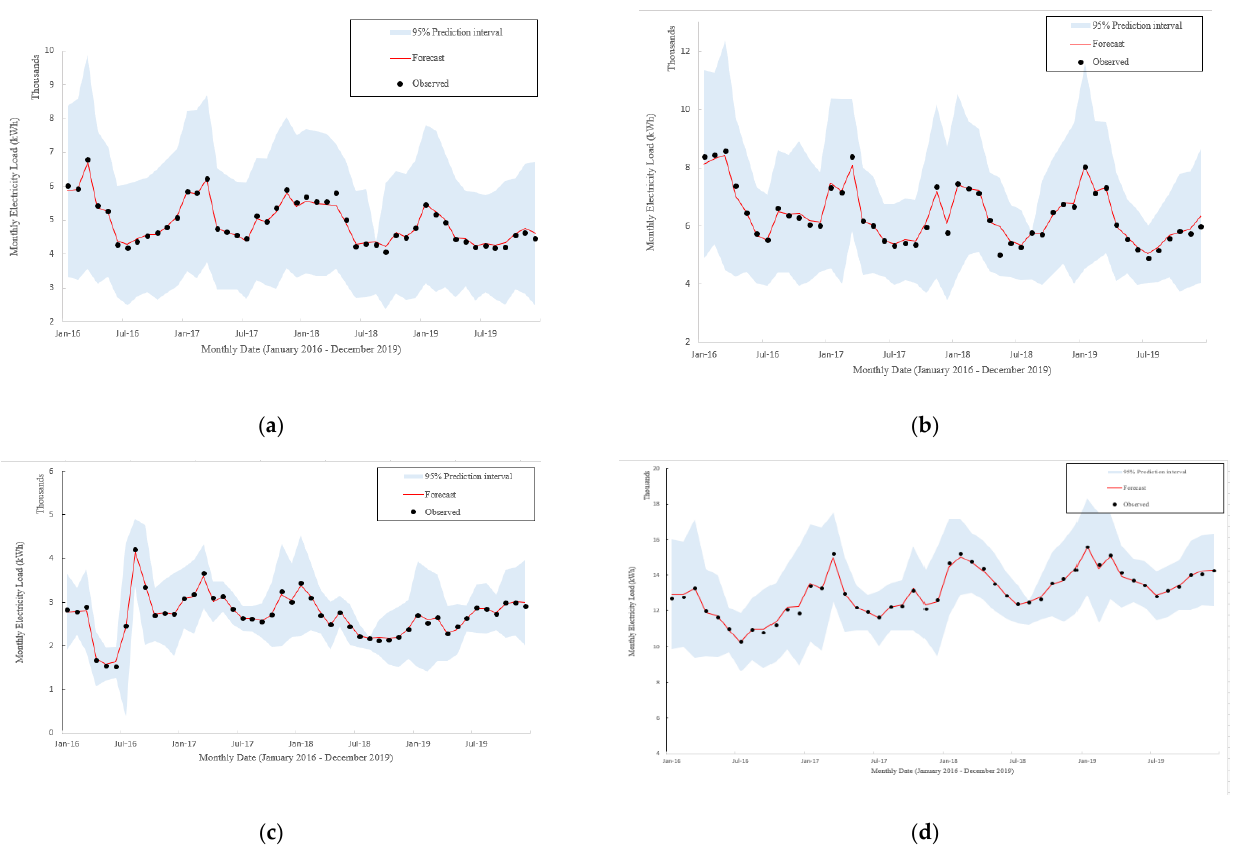
Figure 10. The 95% prediction interval for NARX forecast vs. observed electricity load for all buildings. ( a ) B1, ( b ) B2, ( c ) B3, and ( d )